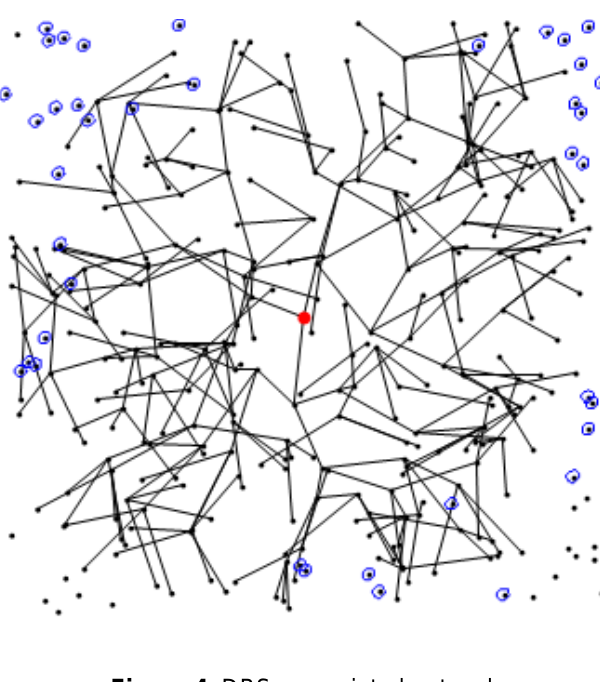
Figure 4. DBS associated